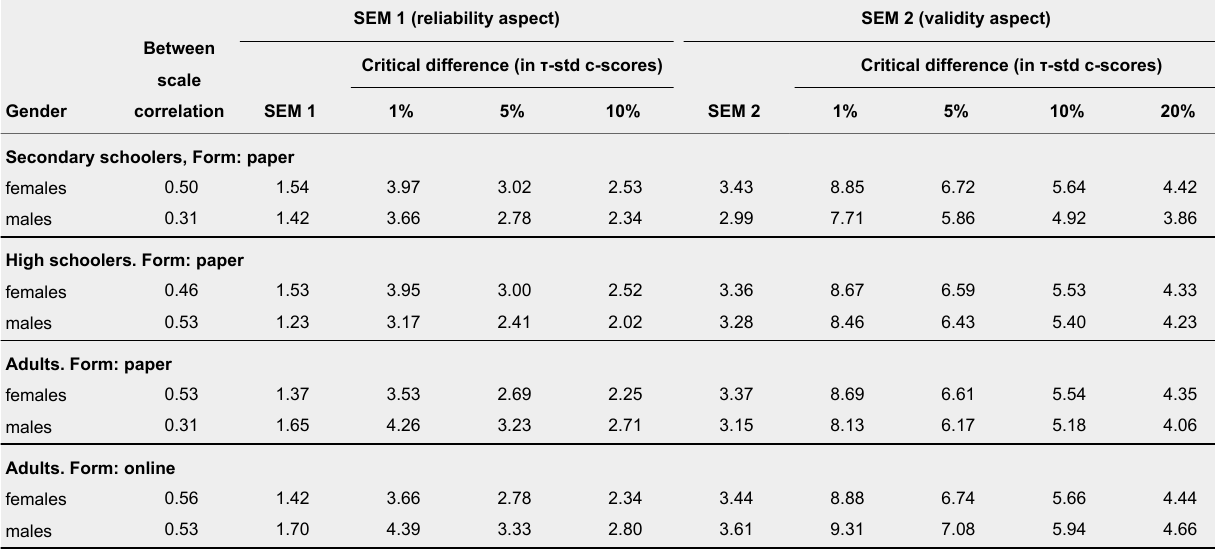
Critical Differences Between Scores at Different Alpha